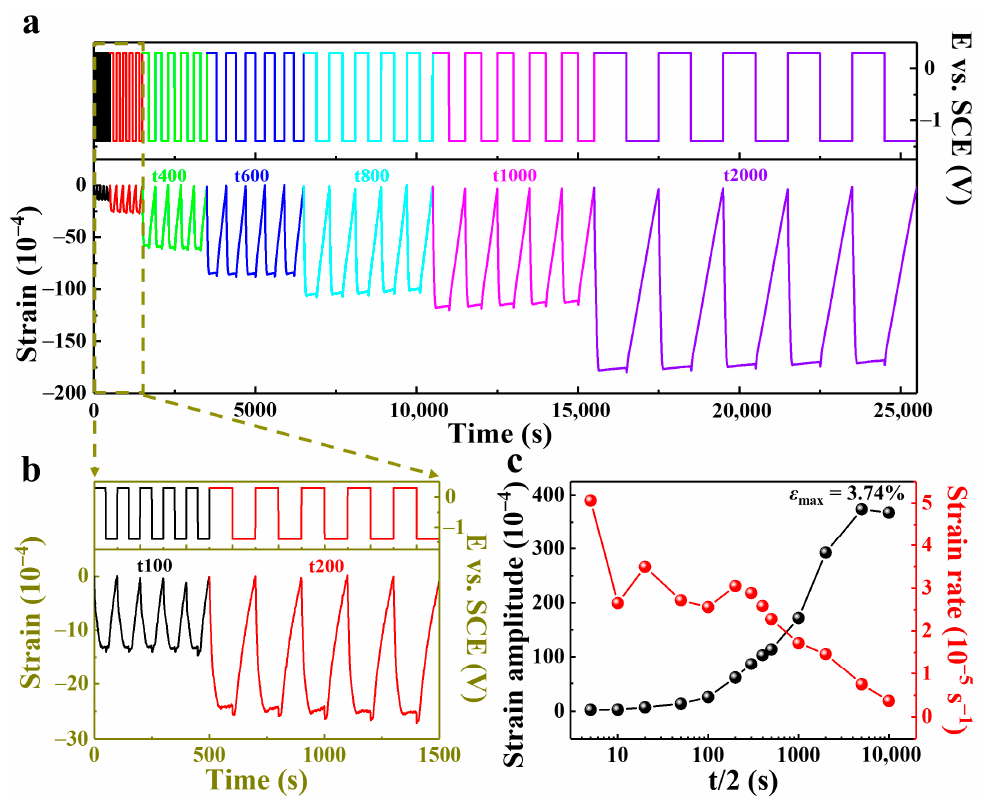
Figure 11. ( a ) SWV-induced strain response of the bulk np-Pd in 0.7 M NaF at different periods from 100 to 2000 s. ( b ) An enlarged region from ( a ). ( c ) Strain amplitude versus t /2.